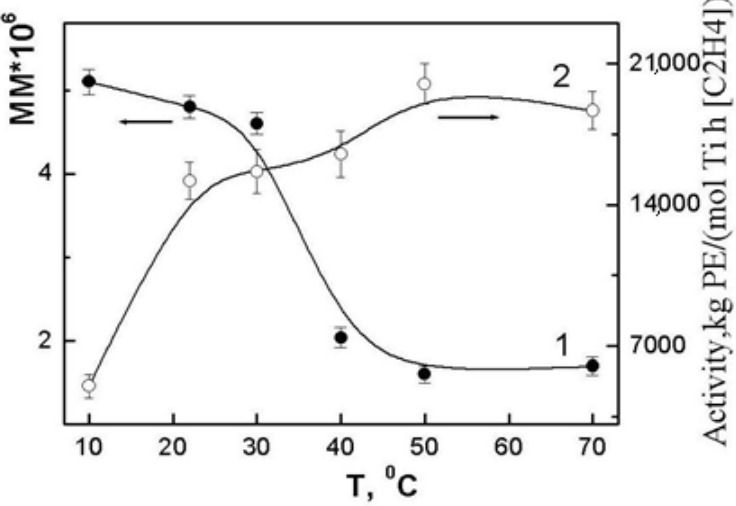
Figure 1. Effect of polymerization temperature on the M v polymers (1) and the activity of the catalytic system (2).